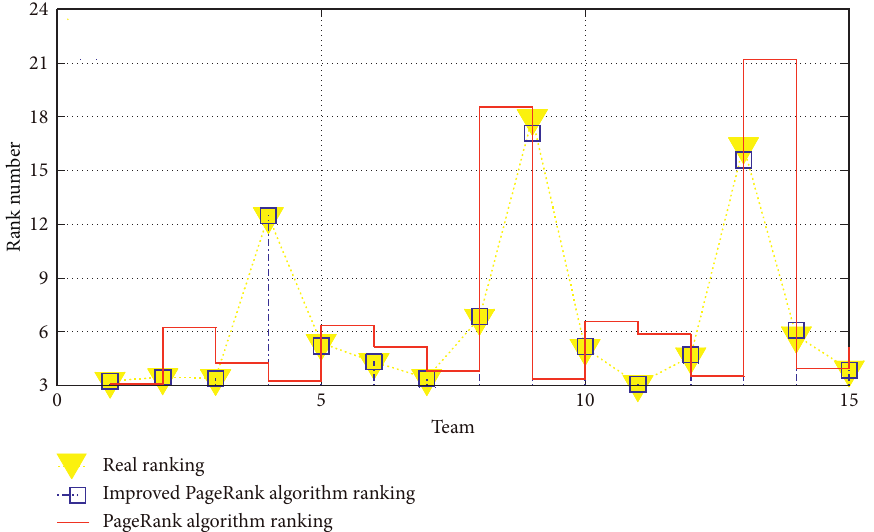
Figure 7: Qualifying prediction of the western conference